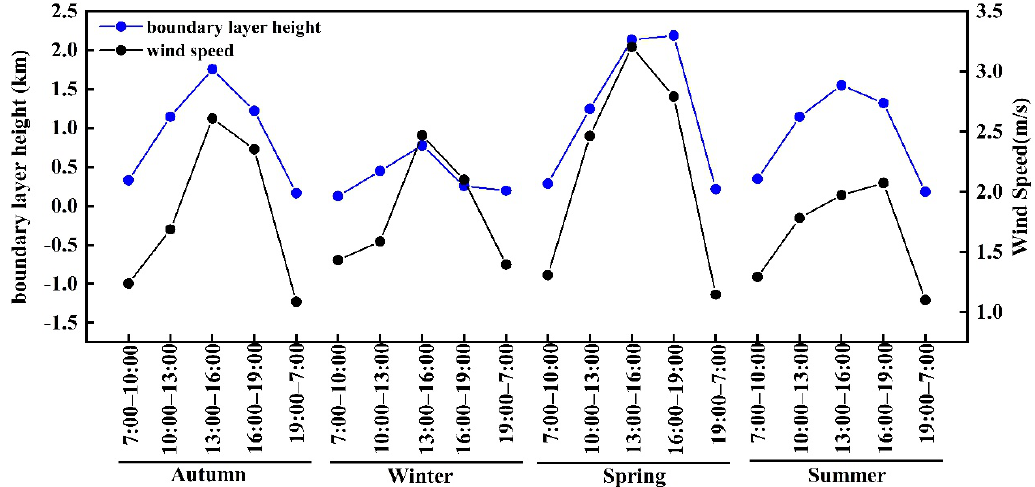
Figure A2. Diurnal variations of wind speed and boundary layer height in four seasons.